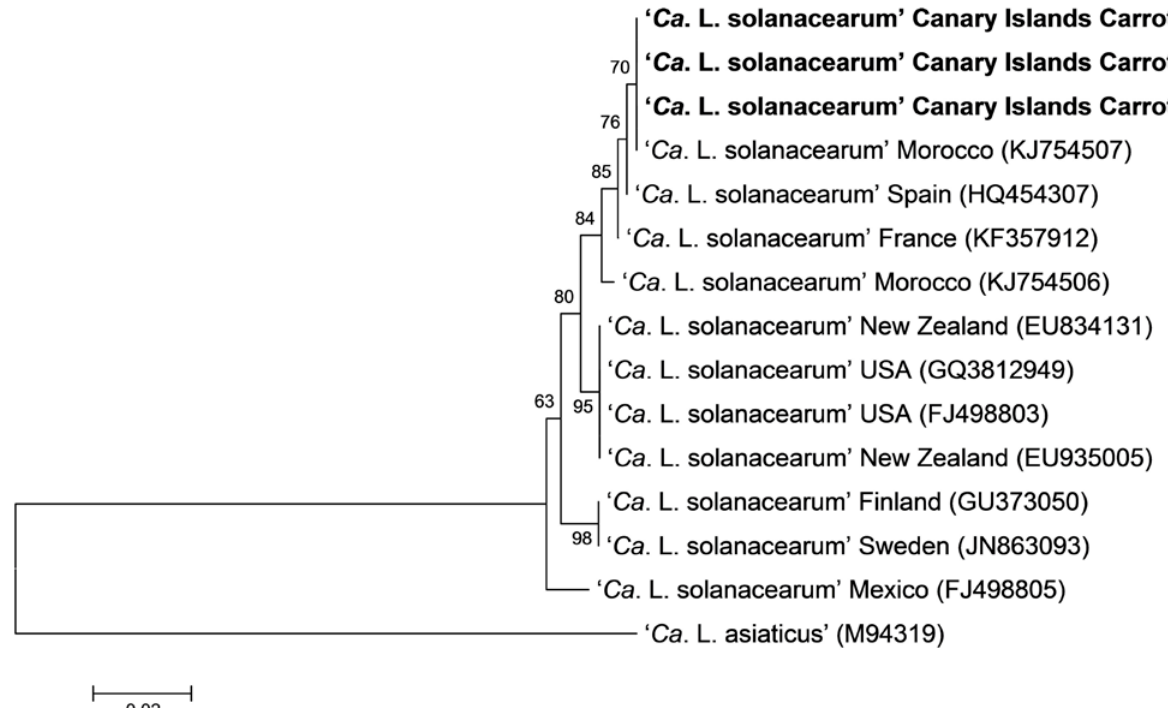
Figure 4. Phylogenetic tree showing the evolutionary history using the Minimum Evolution method enclosing ribosomal protein gene rplJ/rplL sequences from ' Ca . L. solanacearum' from different geographic areas; ' Ca . L. asiaticus' was used as outgroup. In bold sequences of strains obtained from carrots 1, 2 & 7 from Guia, Gran Canaria, Canary Islands, Spain; on the right geographic distribution and in parenthesis GenBank accession numbers. The percentage of replicate trees in which the associated taxa clustered together in the bootstrap test (1,000 replicates) are shown next to the branches (Felsen- stein, 1985). The analysis involved 15 nucleotide sequences. Codon positions included were 1st+2nd+3rd+Noncoding. All positions containing gaps and missing data were eliminated. There were a total of 524 positions in the final